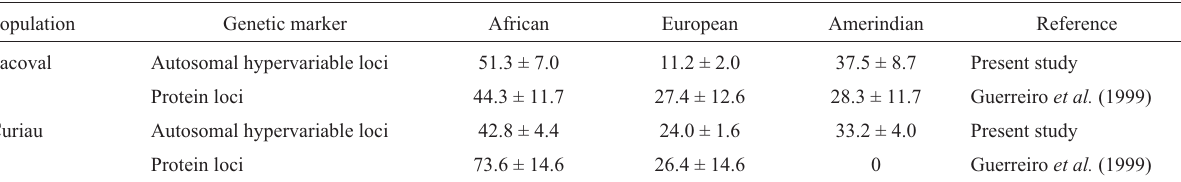
Table 5 - Percentage contribution of African, European and Amerindian gene pools to the Pacoval and Curiau populations, based on classical genetic polymorphisms and Amp-FLPS. Population Genetic